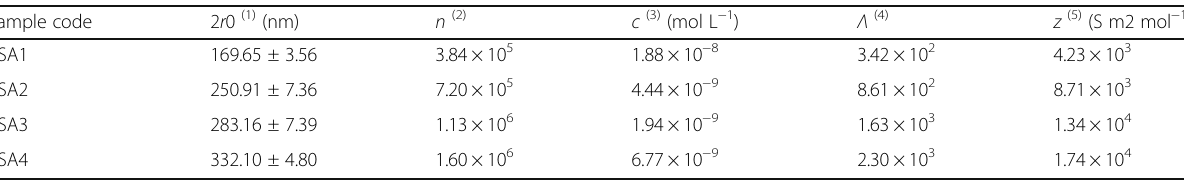
Table 1 Properties of four PSA suspensions